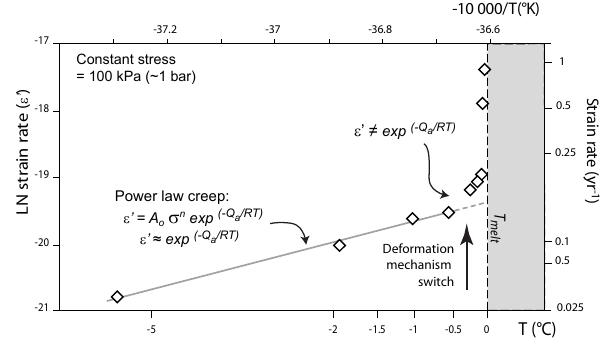
Figure 3. Strain rate against temperature for experiments performed at 100kPa, replotted after Morgan (1991). The x axis plots the re- ciprocal of temperature; y axis plots the natural logarithm of strain rate. Points following the Arrhenius relation within the standard power law should appear on a straight